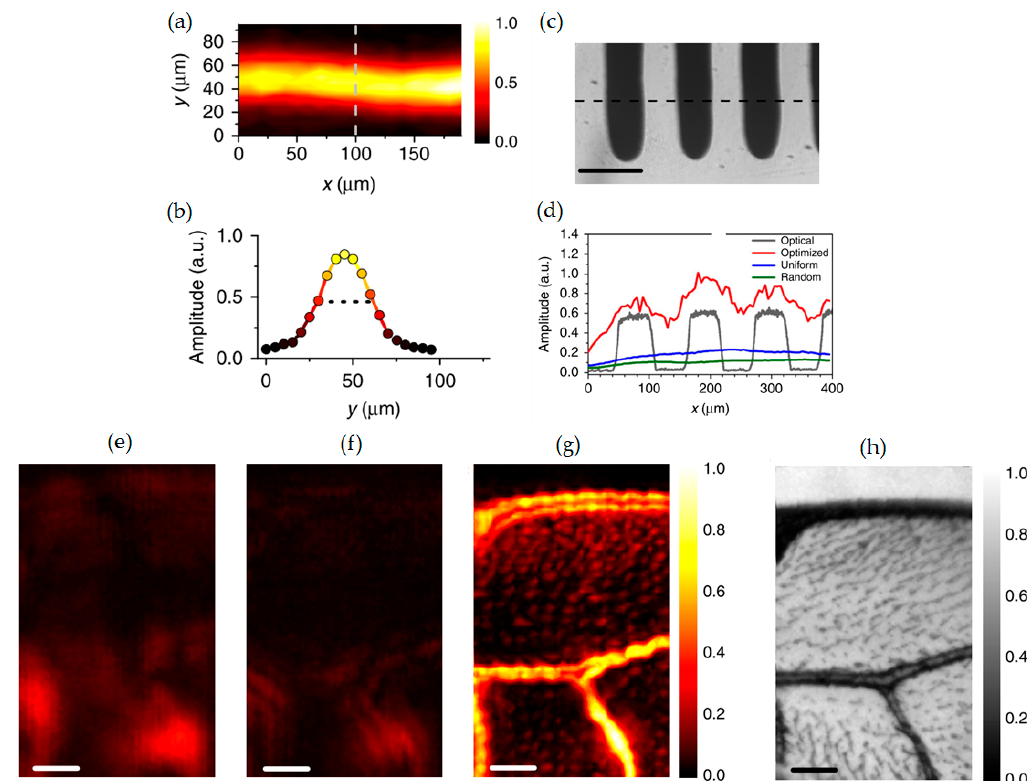
Figure 7. Super-resolution photoacoustic imaging. Scale bar: 100 µ m. ( a ) Photoacoustic image of a black alpaca hair (25 µ m diameter) and ( b ) PA signal intensity profile along the dashed line in ( a ), showing a diameter of 30 µ m defined by the full width of half maximum (FWHM). ( c ) Direct microscopic image of multiple hairs. ( d ) Experimental one-dimensional (1D) scan images with direct optical microscopic, and with uniform, random, and optimized phase compensations, repsctively. ( e – g ) Sweat bee wing images with uniform, random speckle, as well as optimized wavefront illuminations, respectively. ( h ) Direction microscopic image of the bee wing serves as the gold standard for comparison. (Figure from [26]).